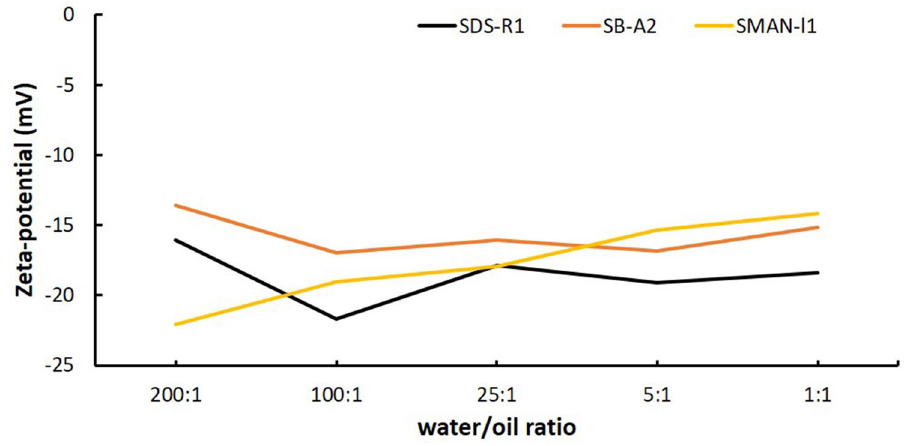
Figure 3. The zeta-potential of oil droplets in ( a ) SDS-R1 (black line), ( b ) SB-A2 (orange line) and ( c ) SMAN-I1 (yellow line) solutions with different water/oil